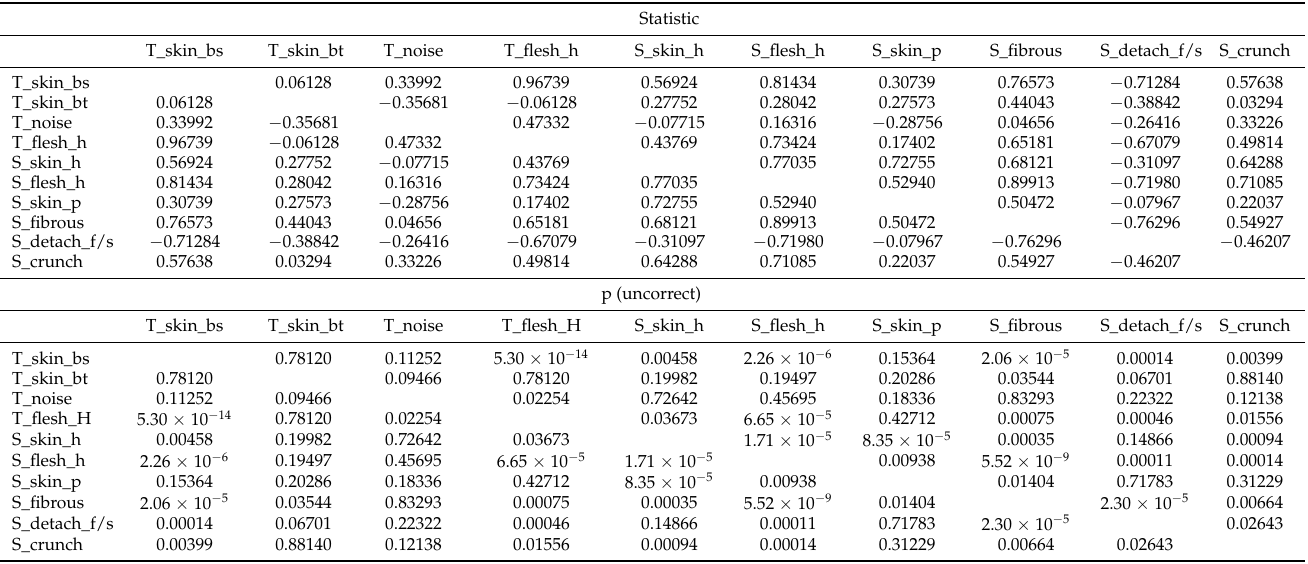
Figure 4. Plot of Spearman’s rank correlations. Table 4. Table of Spearman’s rank correlation values split in two parts: The upper table shows the values of both positive (in blue) and negative (in red) significant